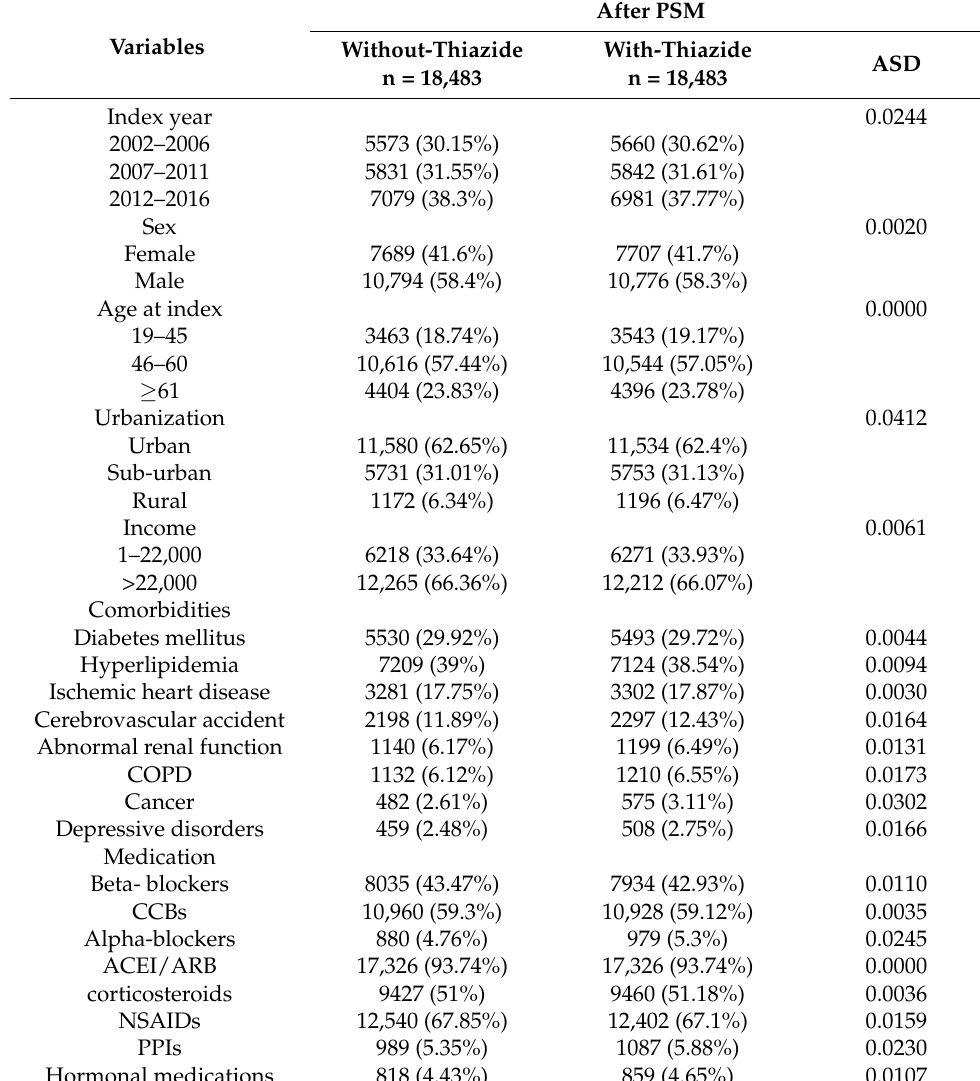
Table 1. Baseline characteristics among study